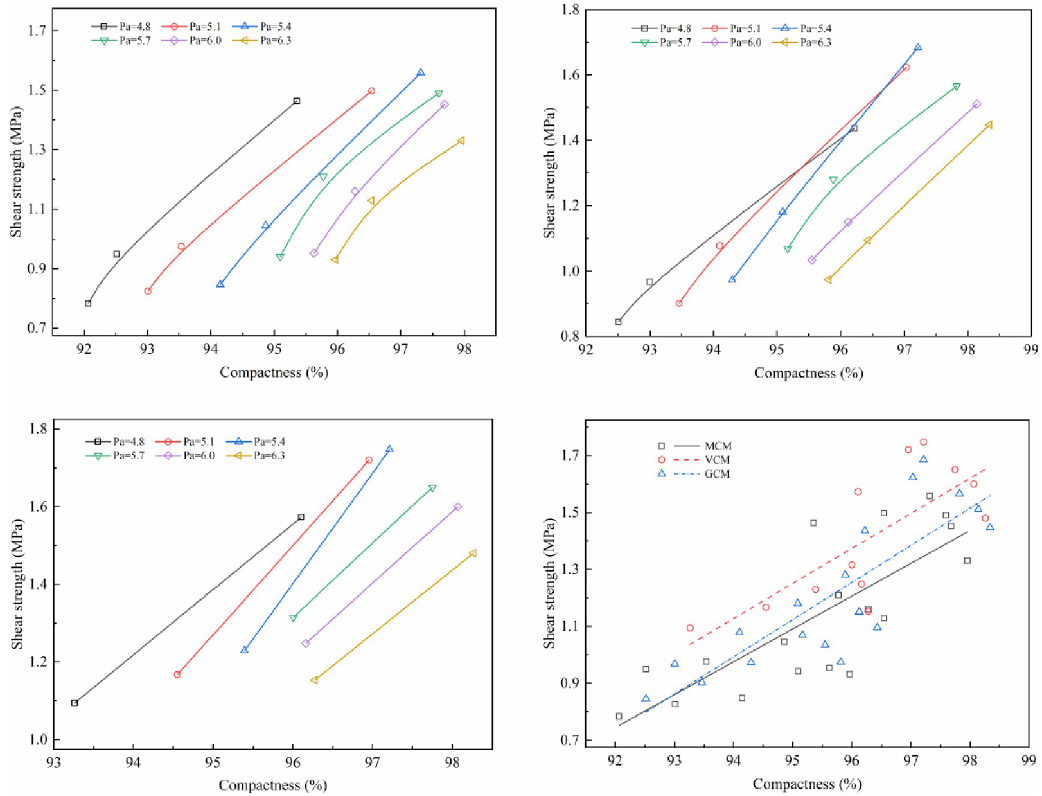
Fig 13. The relationship between shear strength and compactness. (a) Shear strength versus compactness under MCM (b) Shear strength versus compactness under GCM. (c)Shear strength versus compactness under VCM (d) Relationship between shear strength and